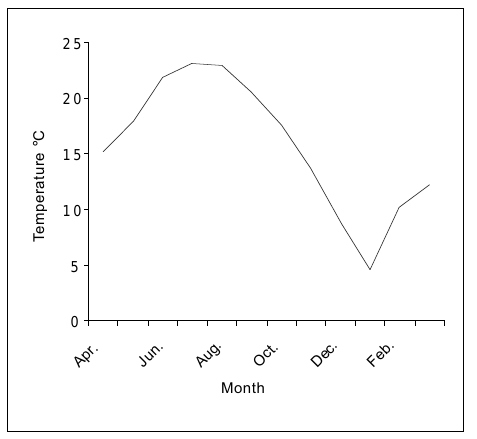
Fig. 1. Average air temperature ( ° C) during 2001–2002 in the Tafila